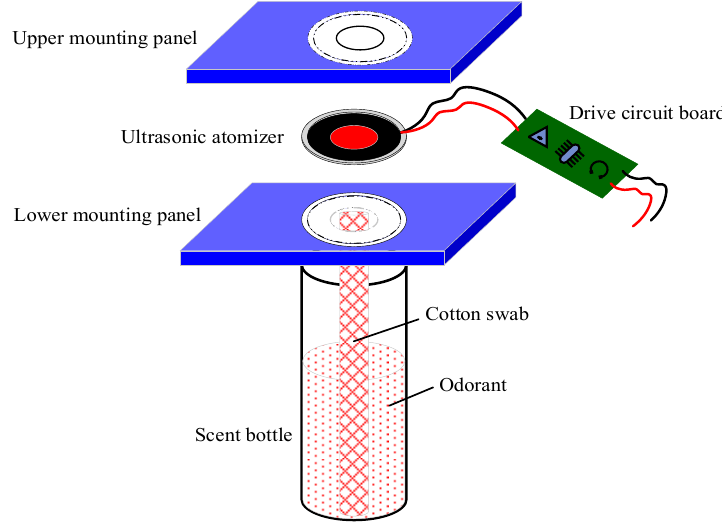
Figure 4. The overall scheme of the odor generator.